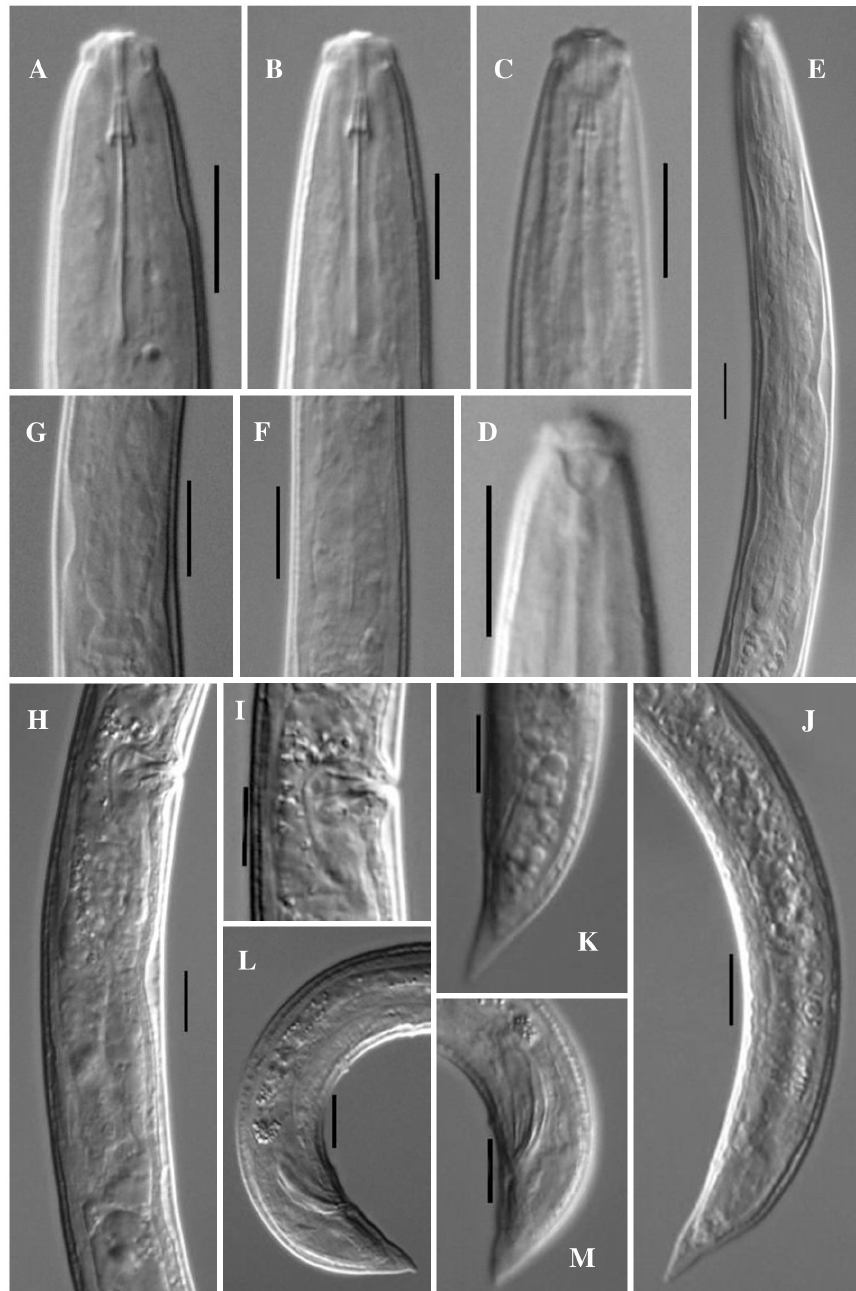
Fig. 15. Basirotyleptus neocaudatus sp. nov. (LM photographs). A, C–D, J–M . Paratypes (AMU/ ZD/NC/ Basirotyleptus neocaudatus /2–4). A, D . Paratype 6, ♀. B . Specimen 14, ♀ (AMU/ZD/NC/ Basirotyleptus neocaudatus /9). C . Paratype 4, ♀. E . Specimen 21, ♀ (AMU/ZD/NC/ Basirotyleptus neocaudatus /11). F . Specimen 24, ♀ (AMU/ZD/NC/ Basirotyleptus neocaudatus /12). G . Specimen 25, ♀ (AMU/ZD/NC/ Basirotyleptus neocaudatus /12). H–I . Holotype, ♀ (AMU/ZD/NC/ Basirotyleptus neocaudatus /1). J . Paratype 2, ♀. K . Paratype 1, ♀. L–M . Paratype, ♂ . A–C . Female, anterior region. D . Female, anterior region showing amphid. E . Female, pharyngeal region. F–G . Female, pharyngeal bulb. H . Female, genital system. I . Vulval region. J . Female, posterior region. K . Female, posterior end. L . Male, posterior region. M . Male, posterior end. Scale bars =10